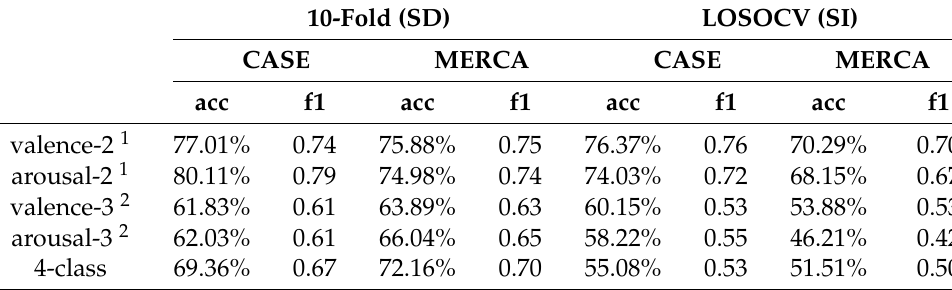
Table 4. Validation results for CASE and